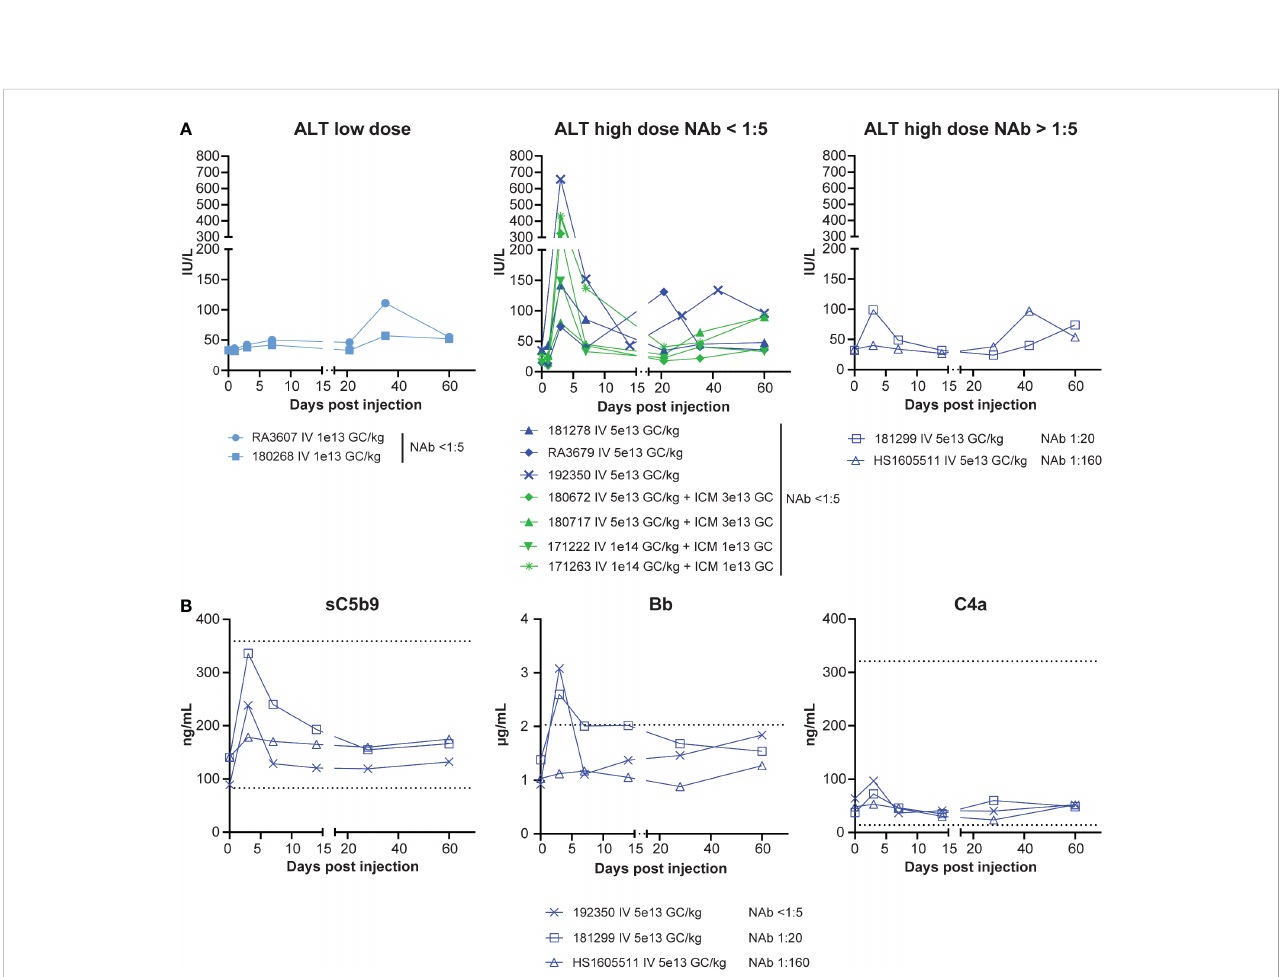
FIGURE 2 Safety, bloodwork. (A) Alanine transaminase (ALT) levels from eleven rhesus macaques that received IV AAVhu68.CAG.vIGF2.hGAA vectors at 1x10 13 GC/ kg (IV low dose) or 5x10 13 GC/kg (IV high dose) or combined IV and ICM at 5x10 13 GC/kg and 3x10 13 GC or at 1x10 14 GC/kg and 1x10 13 GC. Data are separated by dose level and the presence/absence of pre-existing NAbs to AAVhu68. (B) Complement factors sC5b-9 (terminal complex), Bb (alternative-pathway-speci fi c), and C4a (classical-pathway-speci fi c) from three animals presenting no, low, or moderate NAb titers at baseline. Each data point represents a separate peptide pool from an individual